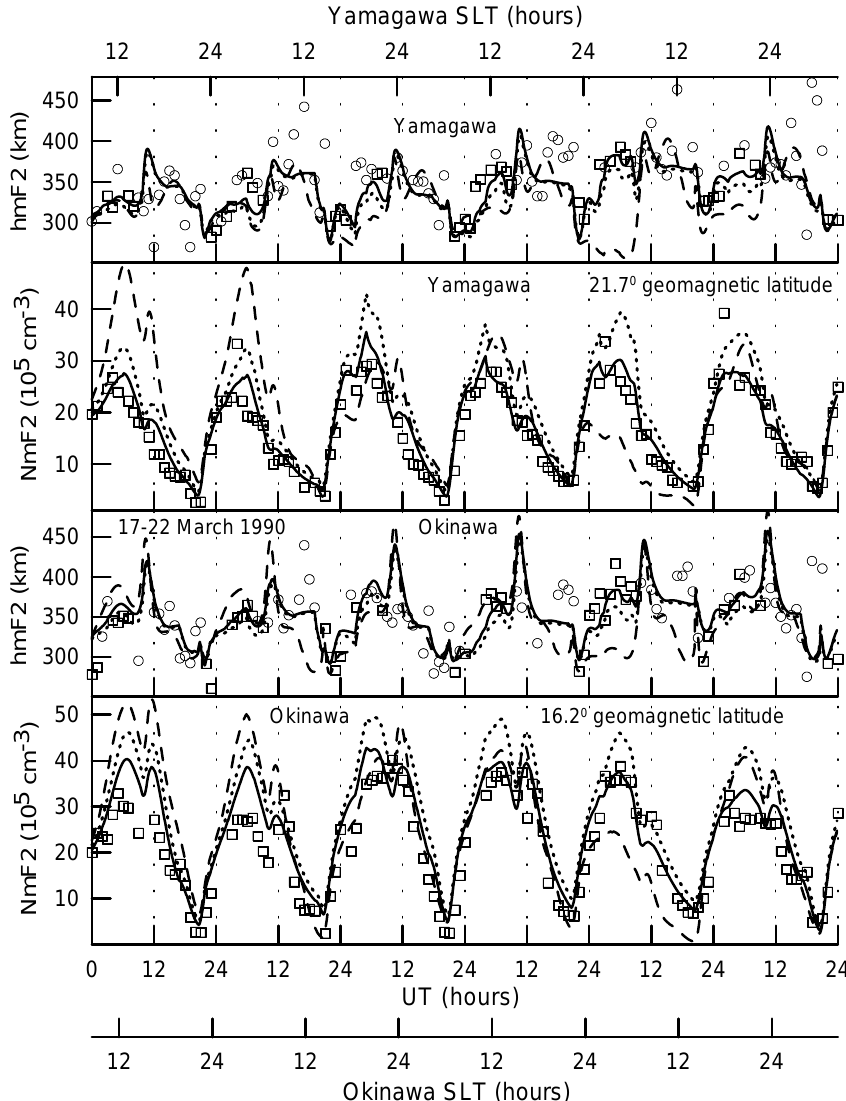
Fig. 5. Observed (squares and circles) and calculated (lines) Nm F2 and hm F2 above the Okinawa (two lower panels) and Yamagawa (two upper panels) ionosonde stations during 17–22 March 1990. The curves are the same as in Fig.